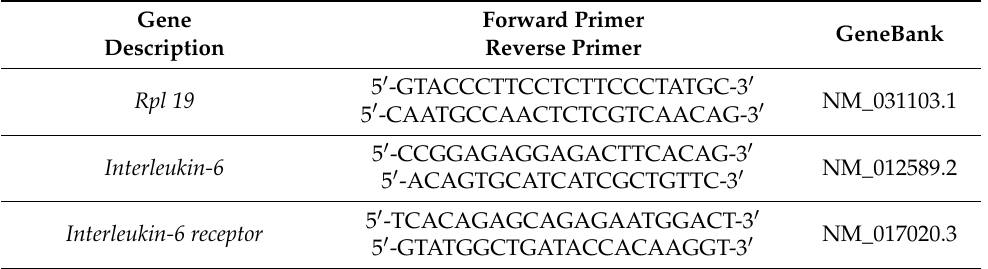
Table 1. Primers used for RT-qPCR